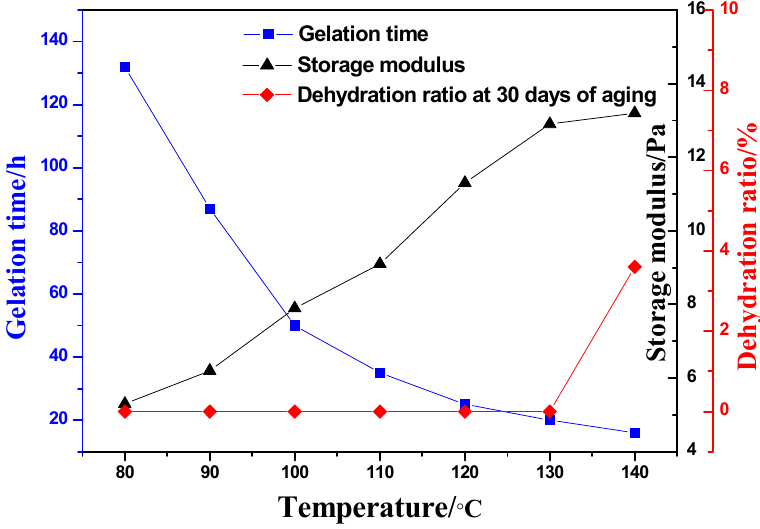
Figure 6. Pictures of gel samples at different heat treatment time.